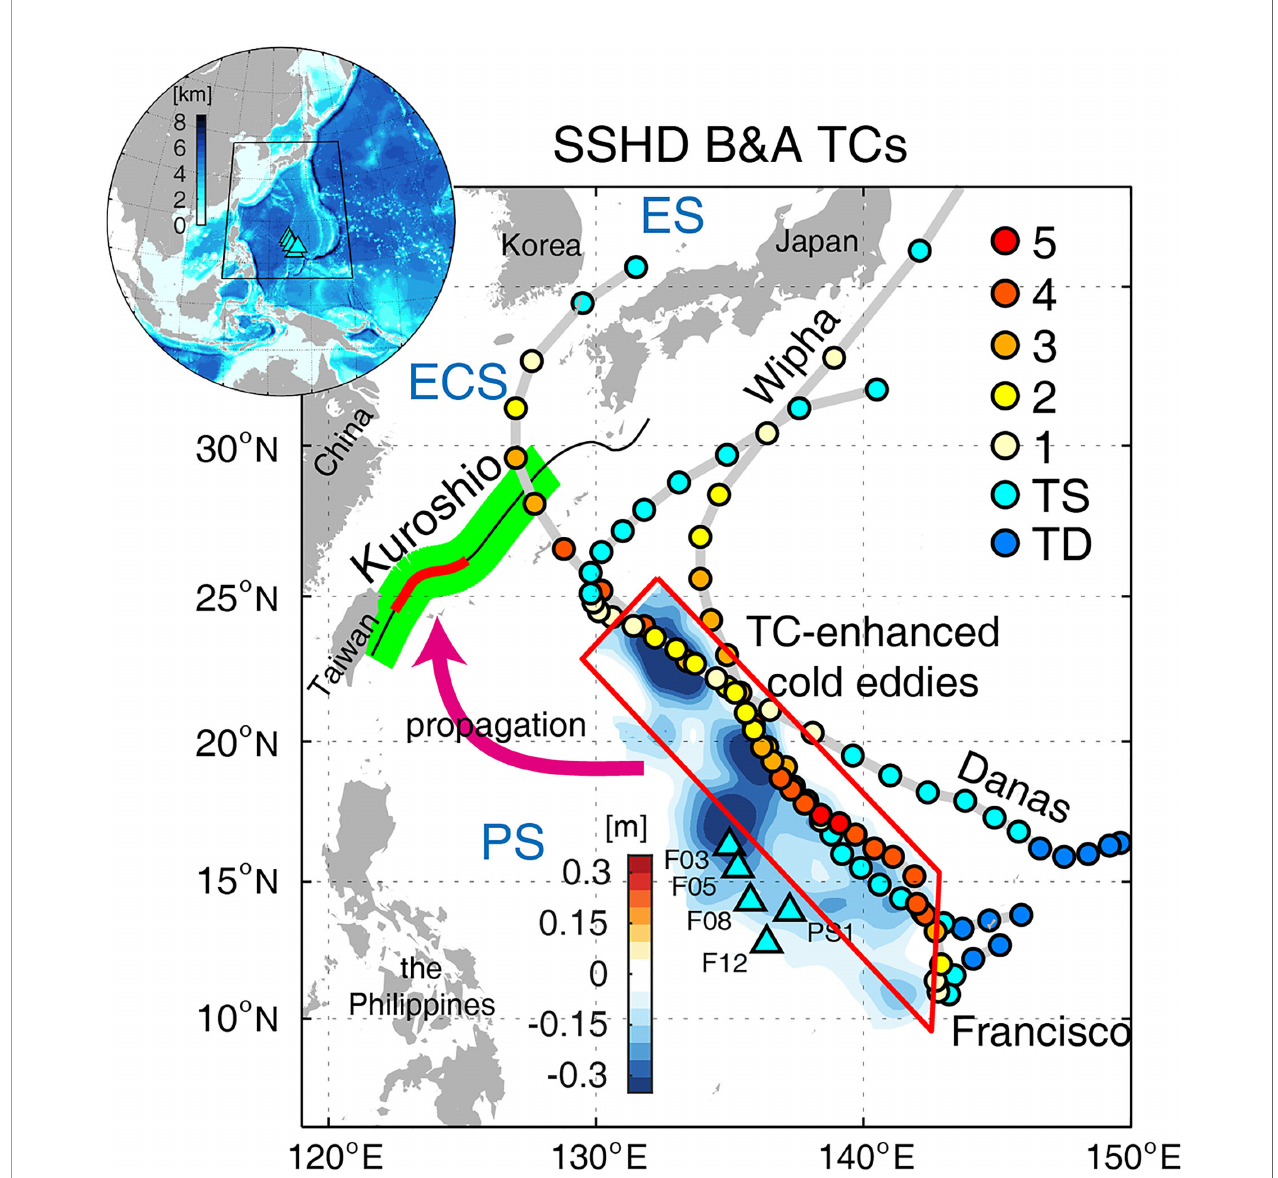
FIGURE 1 | Typhoon tracks (gray solid line) and intensity with Saf fi r – Simpson scale (color dots every 6 h). Background color indicates the sea-surface height (SSH) difference between before (October 5th, 2013) and after (October 31st, 2013) three typhoons (Danas, Wipha, and Francisco). Black solid line extending northeast of Taiwan indicates the mean Kuroshio path, and green indicates perpendicular lines to the Kuroshio path every 10 km. Red line is the Kuroshio upstream used for Kuroshio intensity estimation shown in Figure 7 . Pressure-recording inverted echo sounder (PIES) mooring sites are marked with cyan triangles. Red trapezoid is the calculation region of the ocean heat content (OHC) change. PS, ECS, and ES indicate the Philippine, East China, and East Seas,